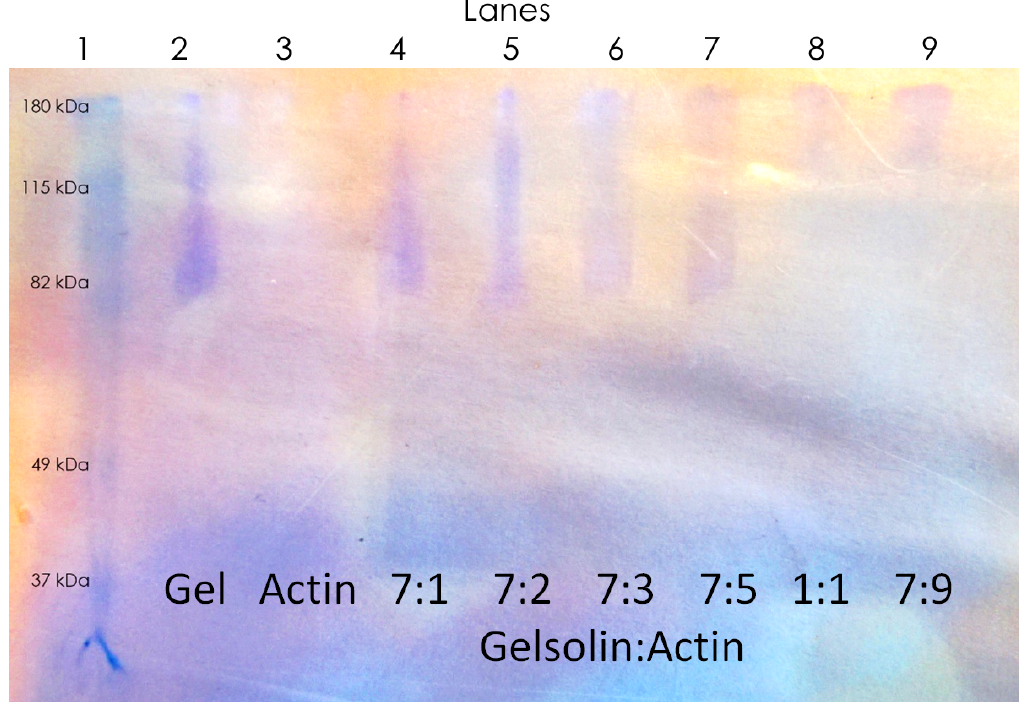
Figure 3. A non-denaturing gel where mixtures of actin and gelsolin were run. Concentration ratios were chosen based on the dissolved concentration of actin.